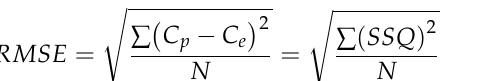
Table 1. The ADE experimental conditions in this